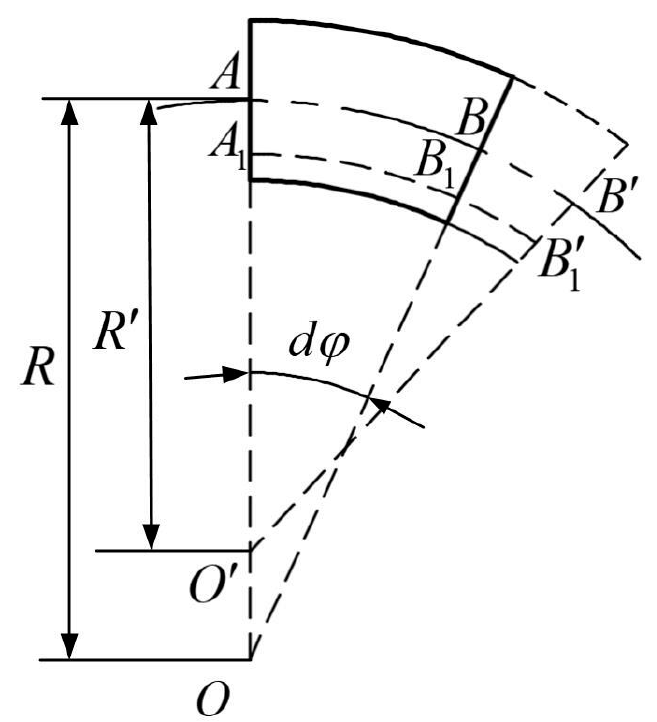
Figure A3. Analysis of deformation at any point on the shell.